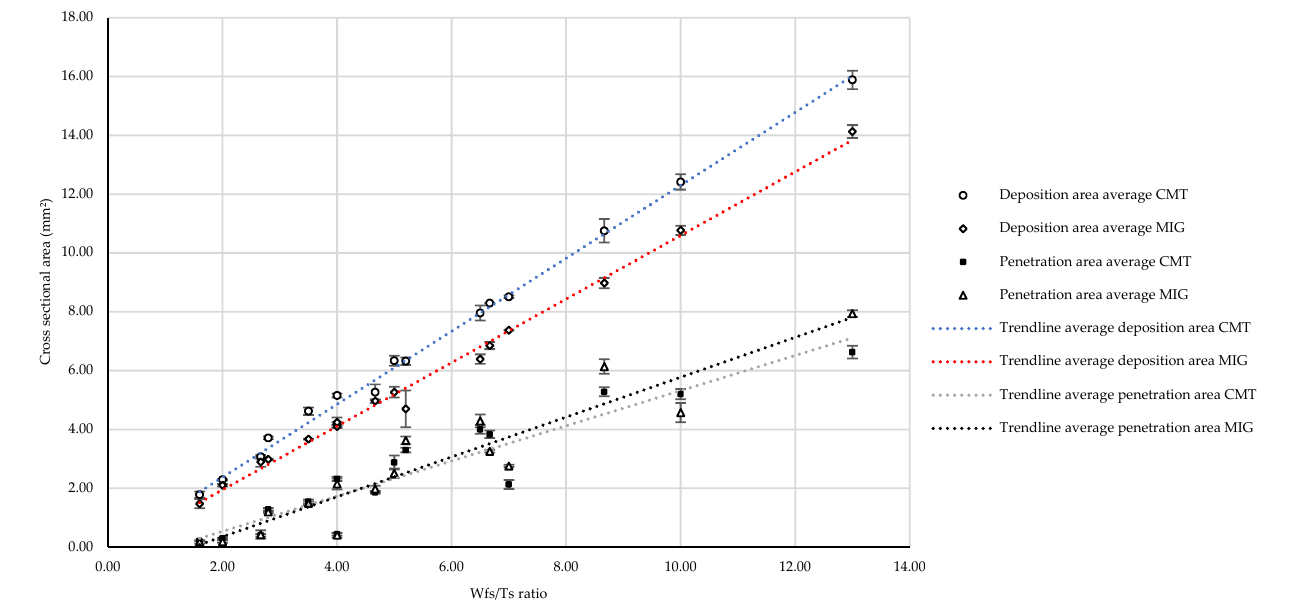
Figure 12. Combined cross-sectional area dimensions with Wfs/Ts ratios. Average standard error values across all parameter sets for the respective deposition areas of each processing mode had similar area error values of 0.145 and 0.146 for CMT and MIG, respectively. A larger level of disparity in error values was observed in the pen- etration areas of samples with 0.103 for CMT and 0.124 for MIG specimens.